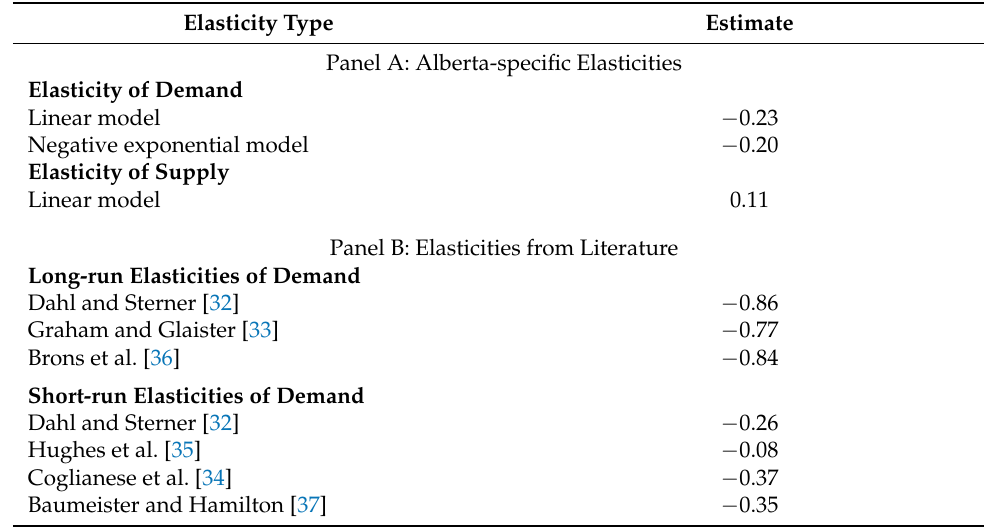
Table 3. Elasticities of Oil Demand and